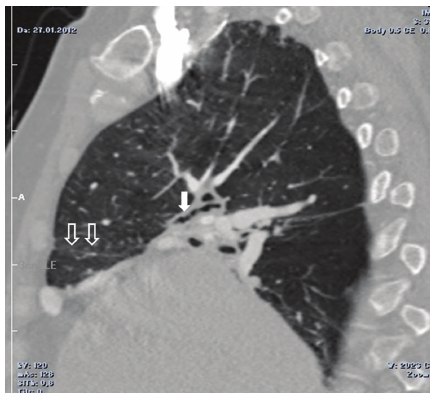
Figure 2: On sagittal CT image, hypoplasia of the right interme- diate and middle lobe bronchus (white arrow), parenchymal scars and loss of ventilation in the middle lobe of the right lung were seen (open arrows).